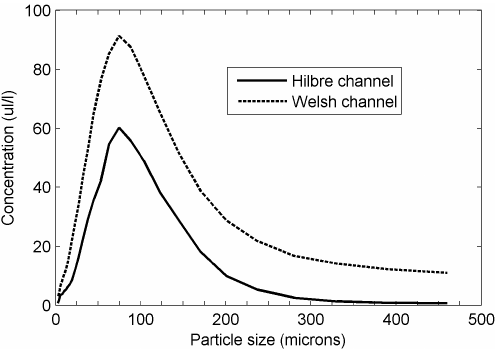
Figure 5. Size distribution of suspended sediment during the first day of deployment.